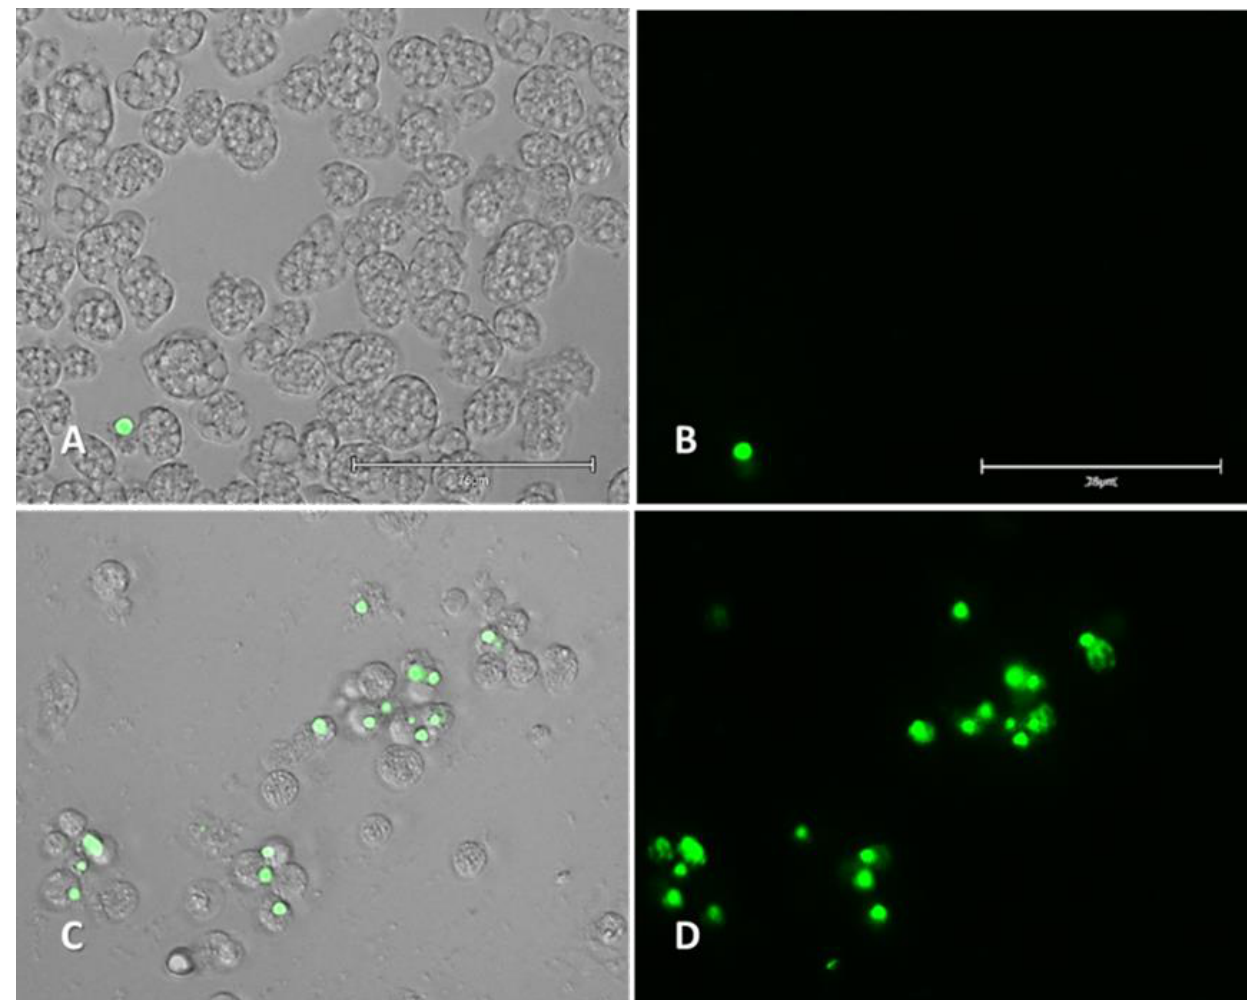
Figure 5. Permeation of the Naegleria fowleri (ATCC ® 30808™) plasma membrane to the vital dye SYTOX green caused by addition of compound 3 ( C , D ) at IC 90 after 24 h. Negative control ( A , B ). Images (40×) are representative of the cell population observed in the performed experiments. Images were obtained using an EVOS™ M5000 Imaging System, Invitrogen by Thermo Fisher Scientific, Madrid, Spain. Scale bars represent 75 µm.